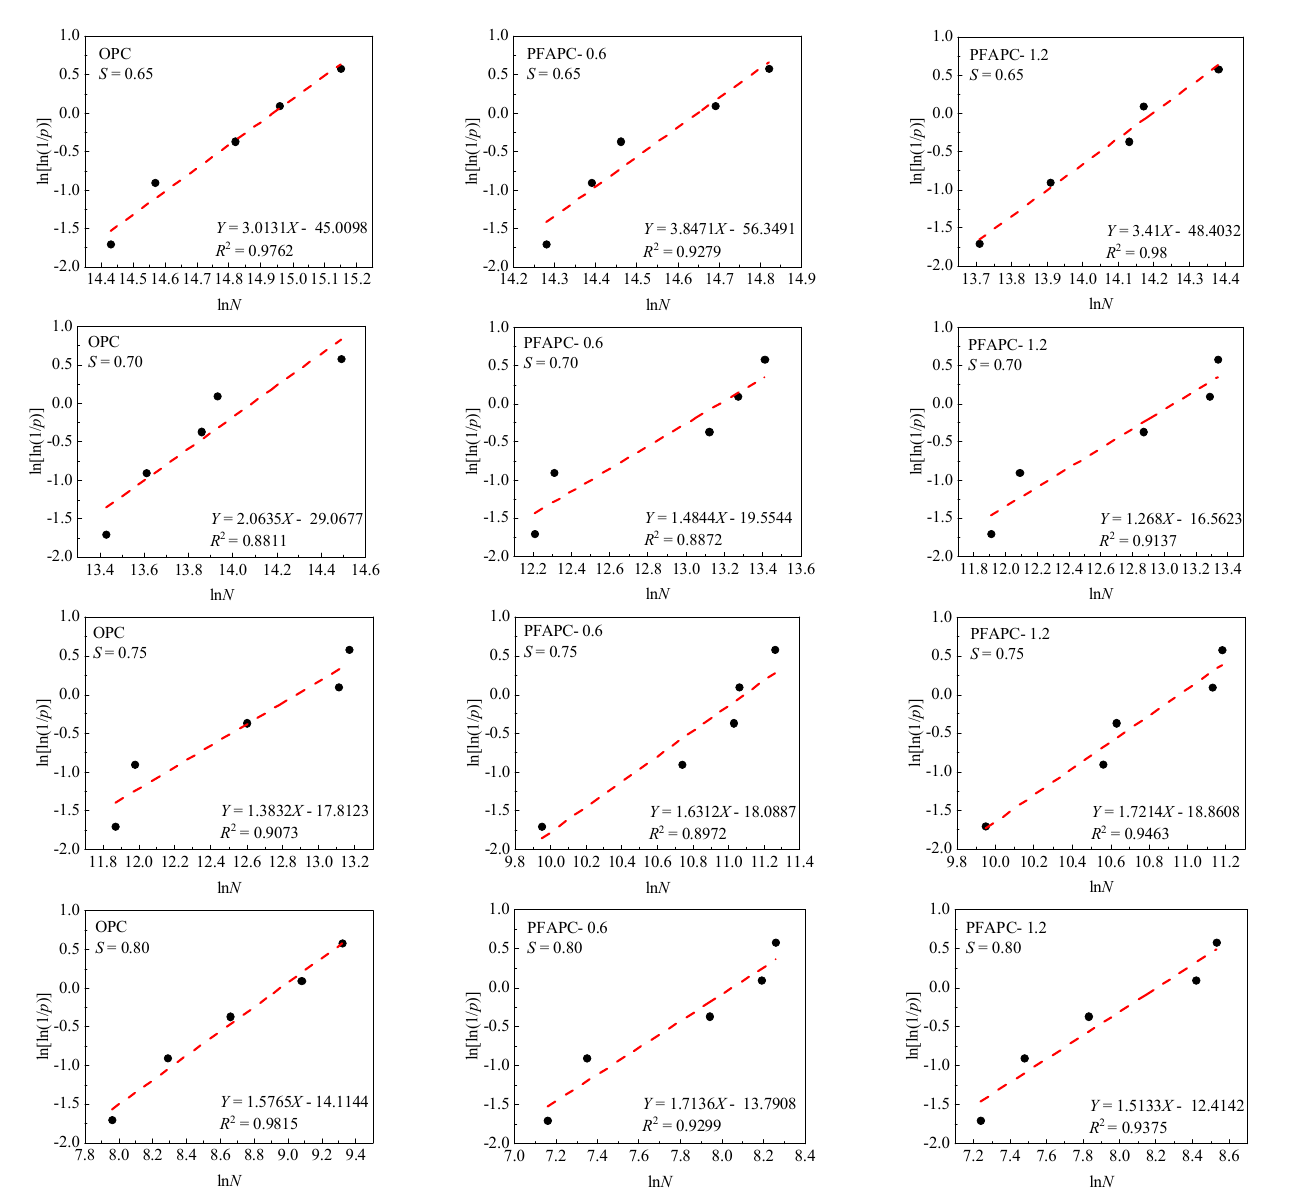
Figure 6. Two-parameter Weibull distribution of fatigue life test results. Figure 6 shows that the OPC and PFAPC test data fitting lines were linear at different stress levels. A strong, statistically significant linear relationship was found between ln[ln(1/ p )] and ln N , and the correlation coefficient R 2 was greater than 0.9. The fatigue life could be described by a two-parameter Weibull distribution. Table 6 provides a summary in Figure Table 6. Linear regression analysis results.